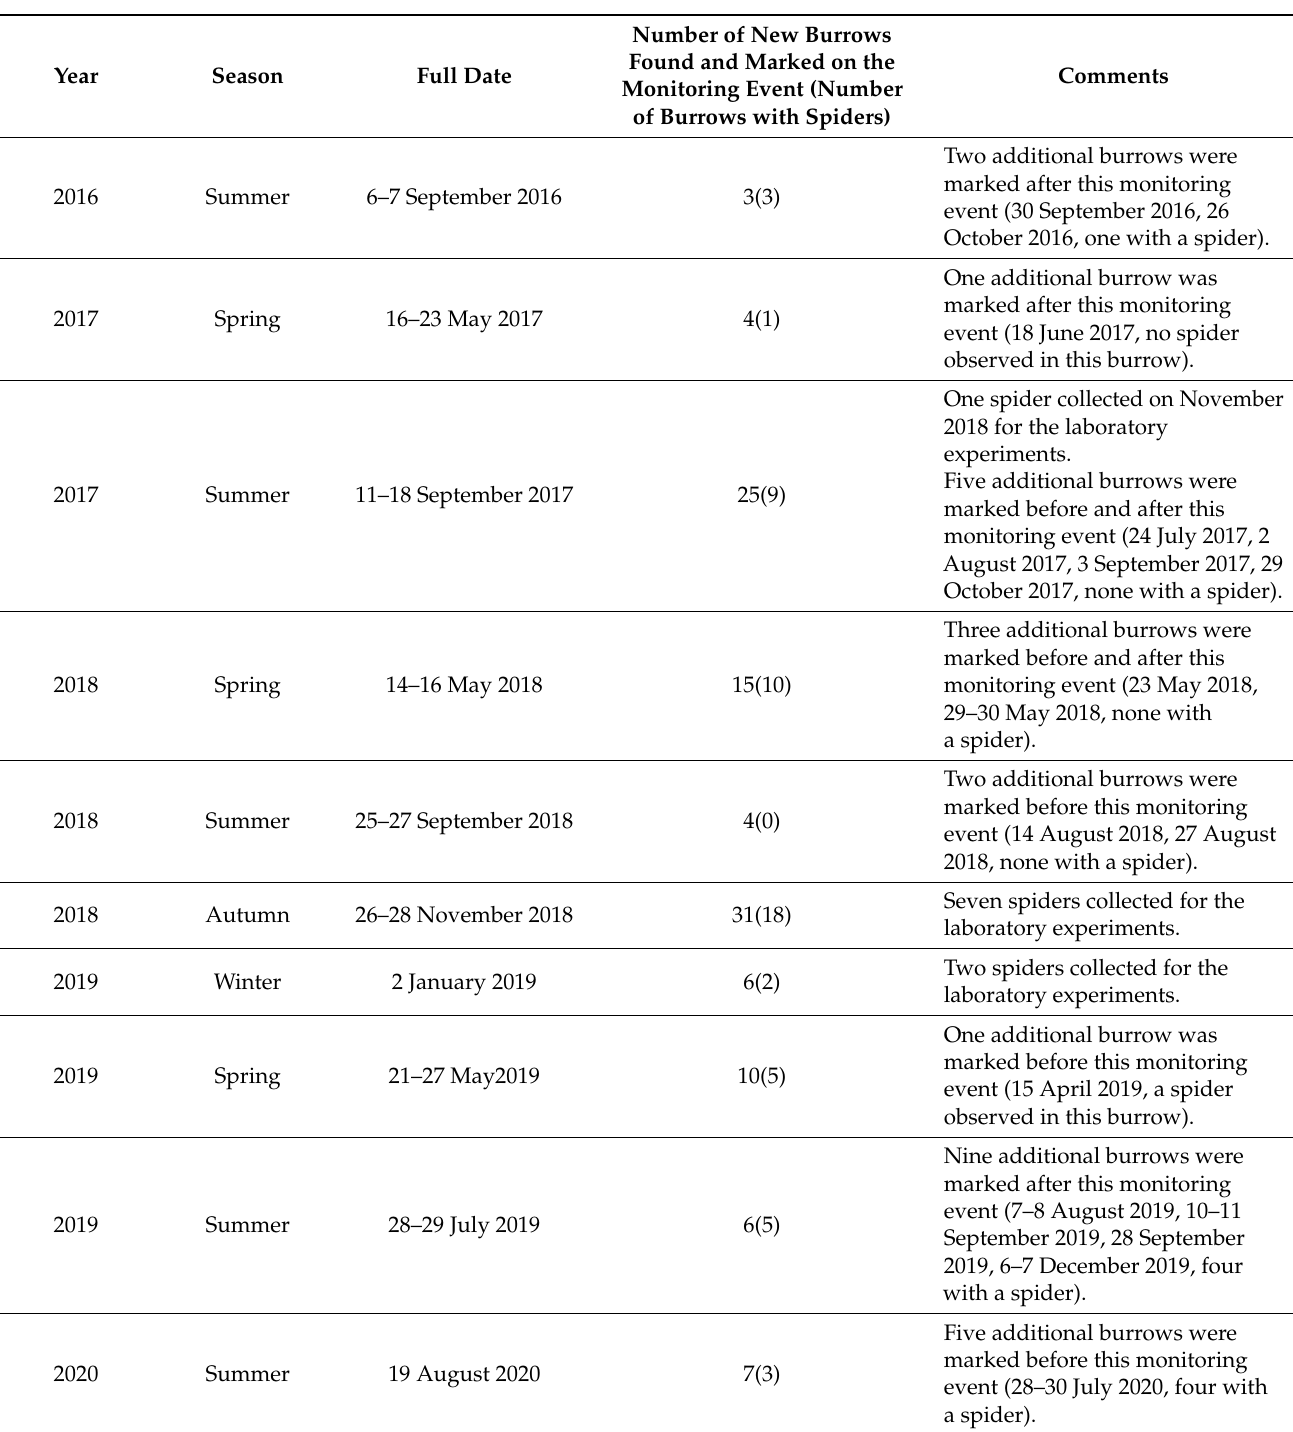
Table A1. List of dates in which the burrows of Sahastata spiders were found and marked at ‘Avrona nature reserve during the five-year